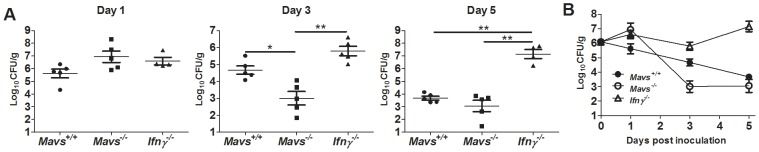
MAVS appears to control S. flexneri growth at early timepoints but is not required for clearance in vivo.(A) Quantification of S. flexneri load per gram of lung tissues. IFNγ
−/−, Mavs
−/−, and Mavs
+/+ were infected intranasally with 3×105 CFU S. flexneri. On indicated days post-infection, lungs were harvested and plated for bacterial CFU enumeration. Statistical differences are indicated as follows:* p<0.05, **, p<0.005 (one-way ANOVA). (B) Quantification of S. flexneri load per gram of lung tissues over time. Data are representative of 3 independent experiments.